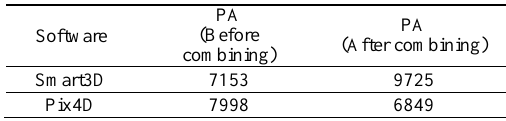
Table 8. Results obtained after combining 17 images